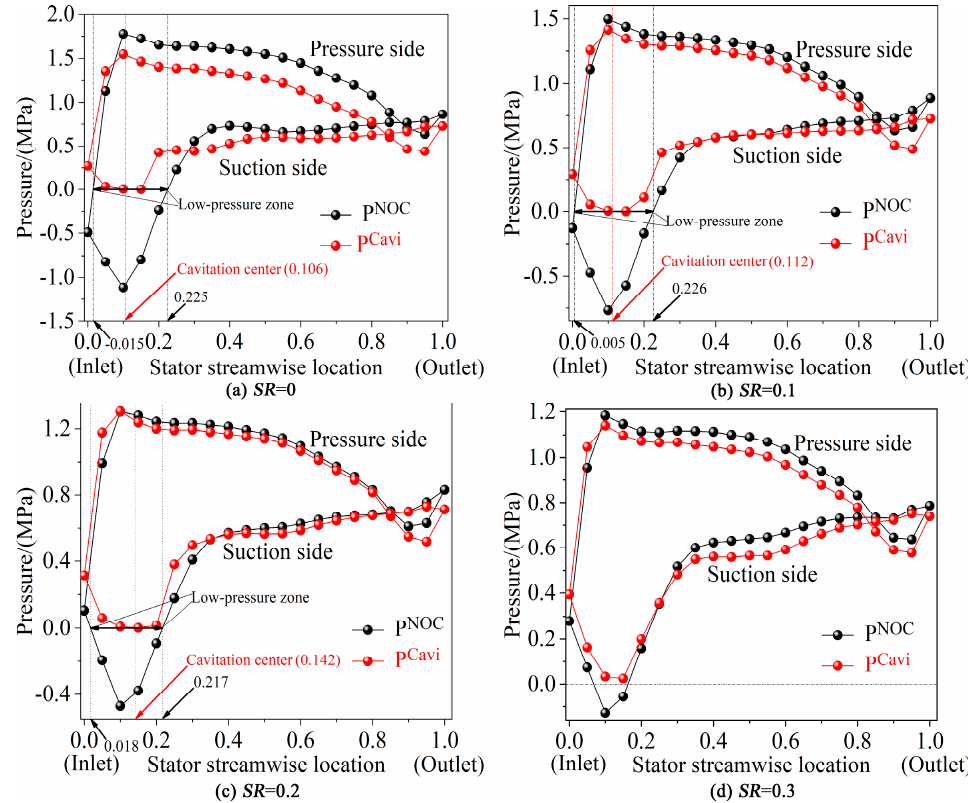
Figure 11. Stator blade load distributions with cavitation and non-cavitation at different SR s. To define the position of the monitoring points around the blade, x is the length of the curve between the points on the camberline and the leading edge of the blade. The intersection of the normal of the bisecting point on the camberline and the blade surface (the intersection point is the position of the blade surface y = 0) is considered and the outer normal of the blade surface is taken as the y direction at this intersection point, and the height of the monitoring point from the blade surface is y . c represents blade camberline length. The definition of camberline for blades can be found in Ref. [30]. The low-pressure region slowly shifted from x /c = − 0.015–0.225 ( SR = 0) to 0.018–0.217 ( SR = 0.2). The cavita- tion center shifted from x /c = 0.106 to 0.142. These results indicate that the cavitation zone moved downstream of the suction surface of the stator blade as the SR increased. The mass flow rate coming out of the turbine and striking the stator blade decreased, which caused the flow stagnation point to transfer from the pressure side to the suction side.